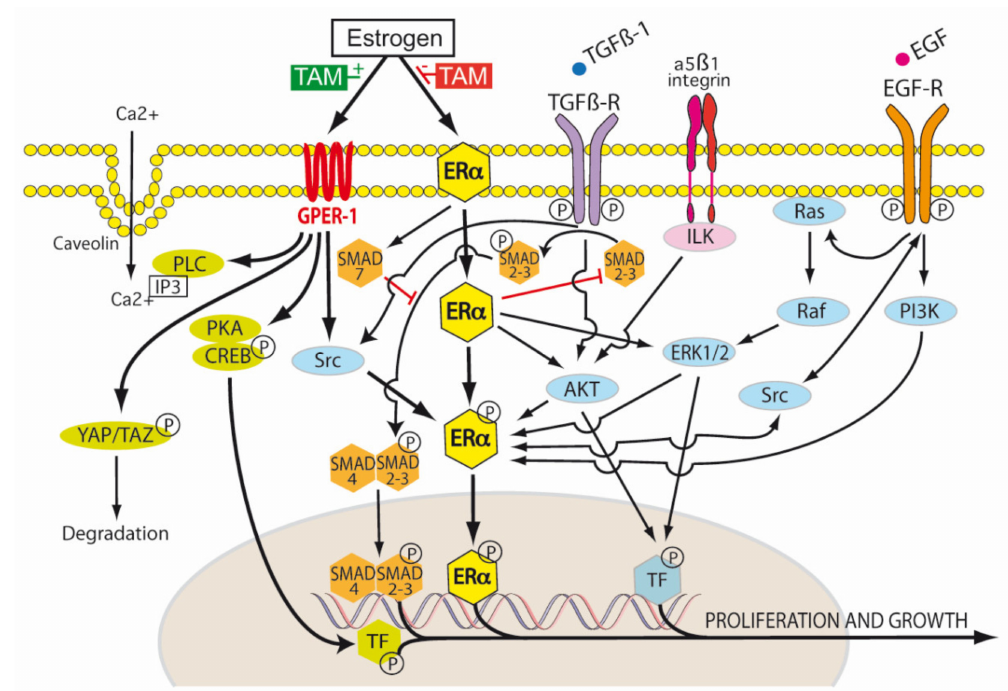
Figure 4. Tamoxifen modulation of membrane and nuclear estrogen receptor (ER) signaling. Transduction of the extracellular environment occurs at the cell membrane. This is mediated by transforming growth factor- β 1 receptor (TGF β -R), integrin linked kinase (ILK), caveolin ion channels and membrane bound receptor tyrosine kinases (RTKs), for example, epidermal growth factor receptor (EGFR). In the TGF- β 1 canonical pathway, TGF- β 1 first binds to T β R-II, and then the recruitment of T β R-I occurs. Both receptors then form the T β R complex, in which T β R-II phosphorylates and activates T β R-I. The active T β R-I then phosphorylates SMAD2 / 3. This results in the cytoplasmic retention of p-SMAD2 / 3 and association with SMAD4. The resulting SMAD complex is translocated to the nucleus and activates SMAD-dependent transcriptional activity. SMAD7 decreases the stability and activity of T β R-I by inducing receptor degradation. SMAD7 also competes with SMAD4 to associate with SMAD 2 / 3. Tamoxifen blocks canonical TGF- β 1 signaling by inhibiting SMAD2 / 3 and promoting SMAD7 (red blockade arrows). The activation of the non-receptor tyrosine kinase Src occurs via the phosphorylation of membrane bound RTKs, including estrogen receptor alpha (ER- α ). There is a reciprocal phosphorylation of Src, ER- α and RTKs—this is dependent, in part, on the tissue levels of tamoxifen and the expression levels of membrane ER- α . Estrogen, tamoxifen and fulvestrant are agonists of G protein-coupled estrogen receptor-1 (GPER-1). Estrogen regulates Hippo signaling via GPER in breast cancer by phospholipase C (PLC), protein kinase C (PKC), Yes associated protein (YAP), and transcriptional coactivator with PDZ-binding motif (TAZ). In ER- α negative breast cancers, GPER activation turns on the Hippo pathway, causing the phosphorylation of YAP and the cytoplasmic retention of pYAP, which is then marked for proteosomal degradation. However, when the Hippo pathway is turned o ff (for example by aberrant Src activation), unphosphorylated YAP is able to be translocated to the nucleus and activate transcription targets. Estrogen receptors also influence non-canonical TGF- β 1 signaling via PI3K (phosphatidylinositol 3-kinase) and Akt (Protein Kinase B) pathways. Tamoxifen can act as an ER- α antagonist in some tissues (breast) and an ER- α agonist in others (endometrium, osteoblasts, endothelium), hence its pleiotropic e ff ects. It is thus classified as a selective estrogen receptor modulator (SERM)